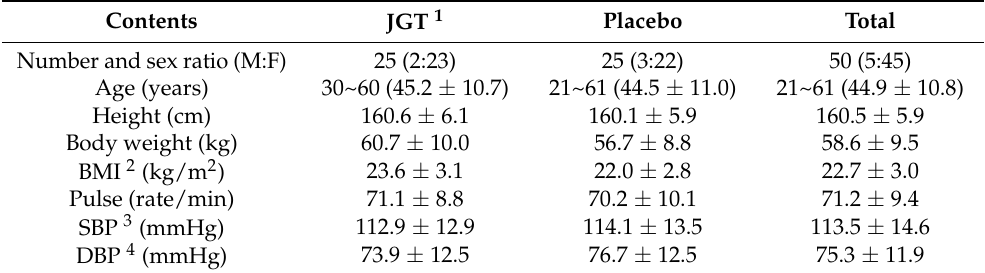
Table 2. Baseline characteristics of